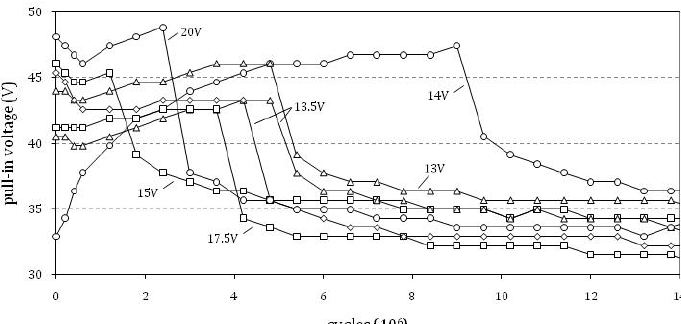
Figure 9: Pull-in voltage of different testing devices (design 1) during the accumulation of fatigue loading, with alternate load being provided at 20kHz frequency at the amplitude V a indicated for each curve. The pull-in voltage was measured and stored at specific time intervals. The specimen failure is indicated by the strong pull-in reduction (ranging from 12.9% and 22.7% of its last value).